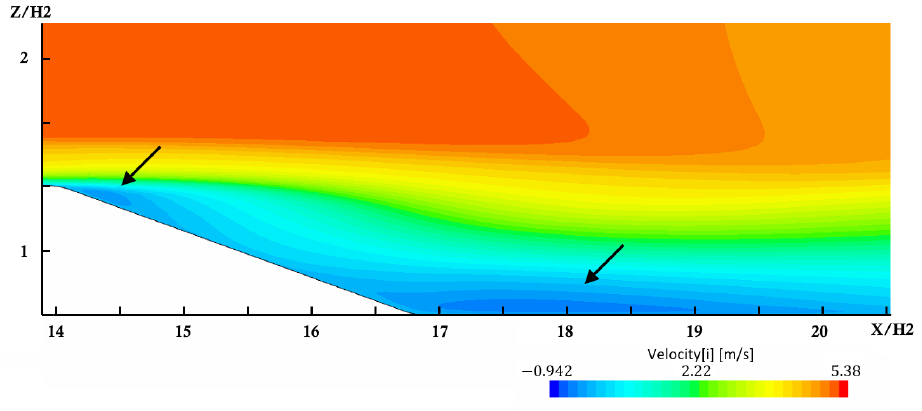
Figure 14. Simulated flow separation affected by the knitted wire mesh with two rows. The velocity in the horizontal direction is shown on the plane R in between two stitches. The arrows indicate recirculation